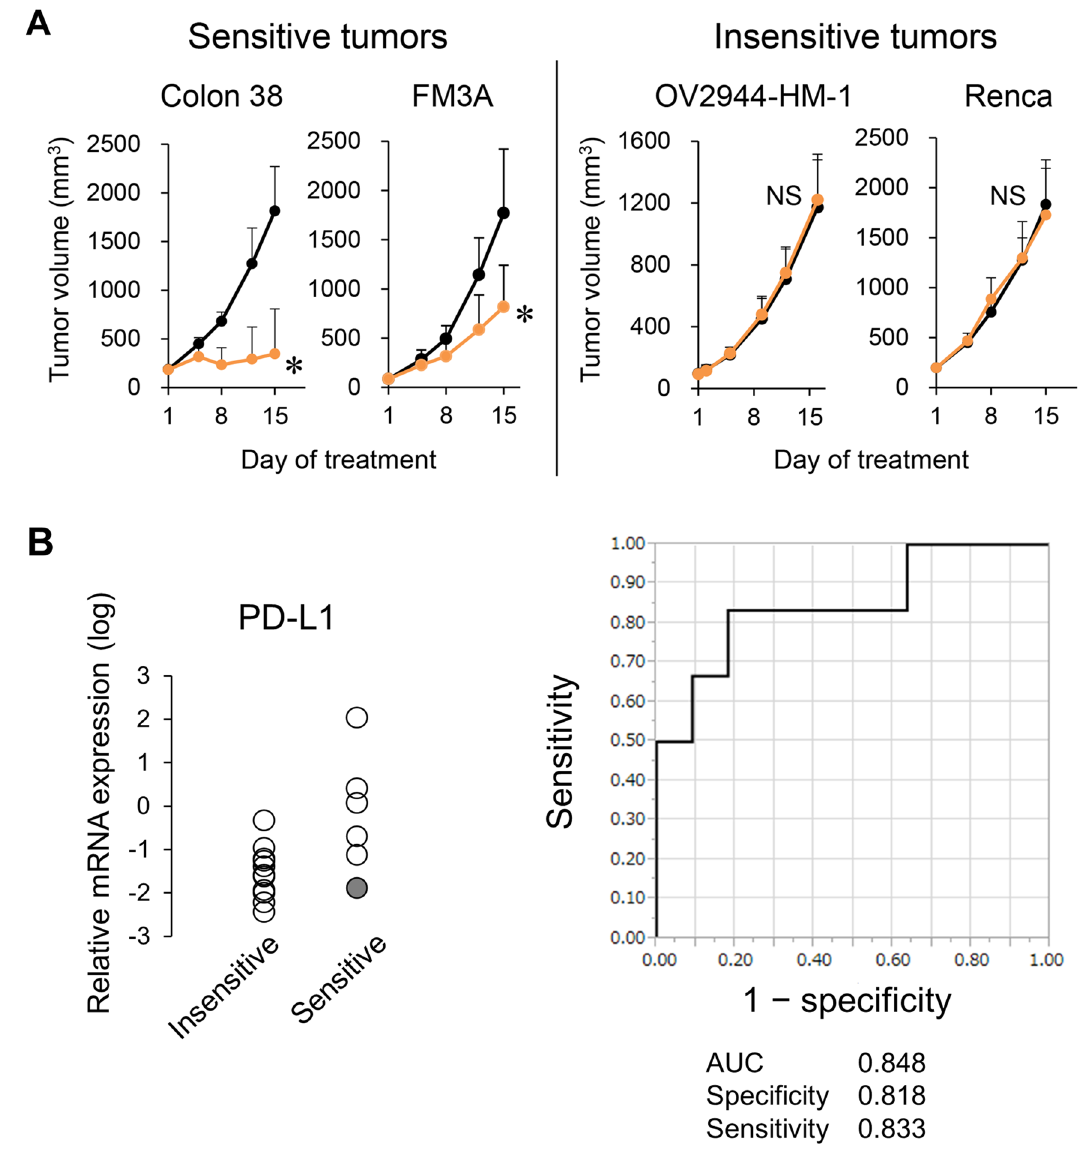
Figure 1. Relation between antitumor activity of anti-PD-L1 mAb and PD-L1 expression. ( A ) Representative tumor growth curves: mice bearing tumors were randomly divided into groups. Anti-mouse PD-L1 mAb or Rat IgG was administered intraperitoneally to the mice at a dose of 10 mg/kg three times a week. Black, control; orange, anti-PD-L1 mAb 10 mg/kg. Data are shown as the mean + SD ( n = 5–15/group). Statistical analysis used Wilcoxon rank sum test. * P < 0.05; NS not significant. ( B ) PD-L1 mRNA expression in tumor tissues at baseline insensitive or sensitive to anti-PD-L1 mAb (left), and ROC curve analysis (right). Shaded circle indicates results for the FM3A